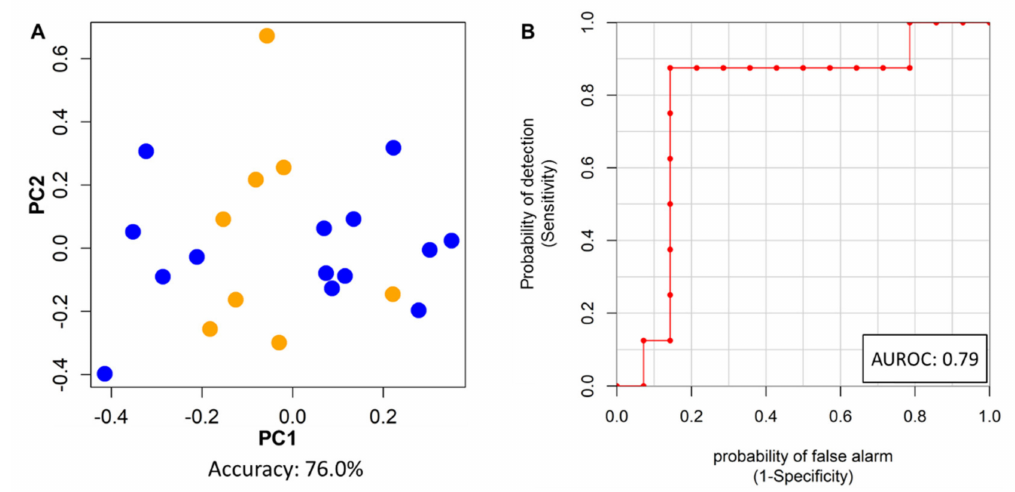
Figure 4. ( A ) PCA-CA of 1 H NMR CPMG spectra of baseline plasma samples from ER( + ) patients who developed disease recurrence (orange) and those who were disease free at 10 years (blue). Model LOOCV accuracy of 76.3%, p -value = 0.020. ( B ) ROC curve of the linear combination of IL-2 and IL-10 to distinguish relapsed and not relapsed ER( + )